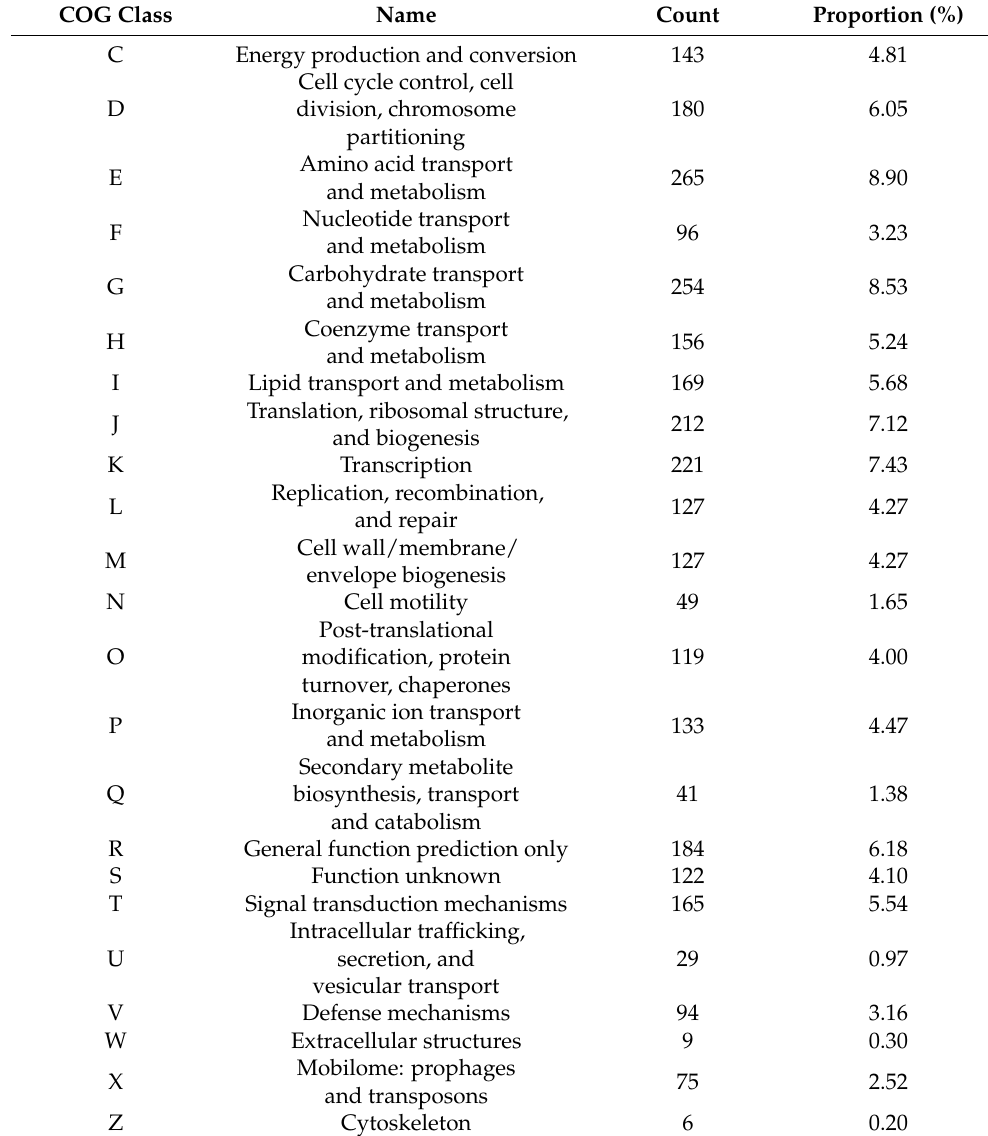
Table 3. COG categories of coding proteins in W. coagulans